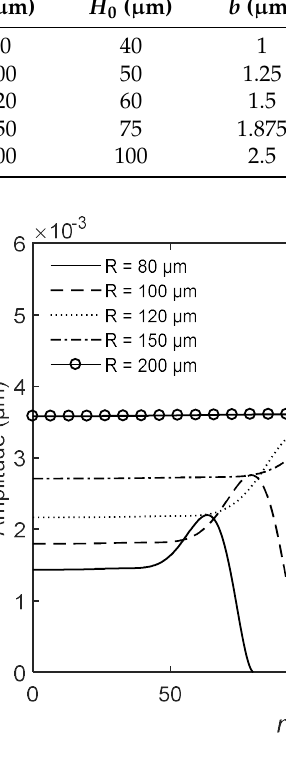
Figure 10. The amplitude distribution of the bionic structure for different scales with constant ratio R : H 0 : b = 80:40:1. Table 6. The first natural frequencies of the bionic structures of different scales with constant ratio